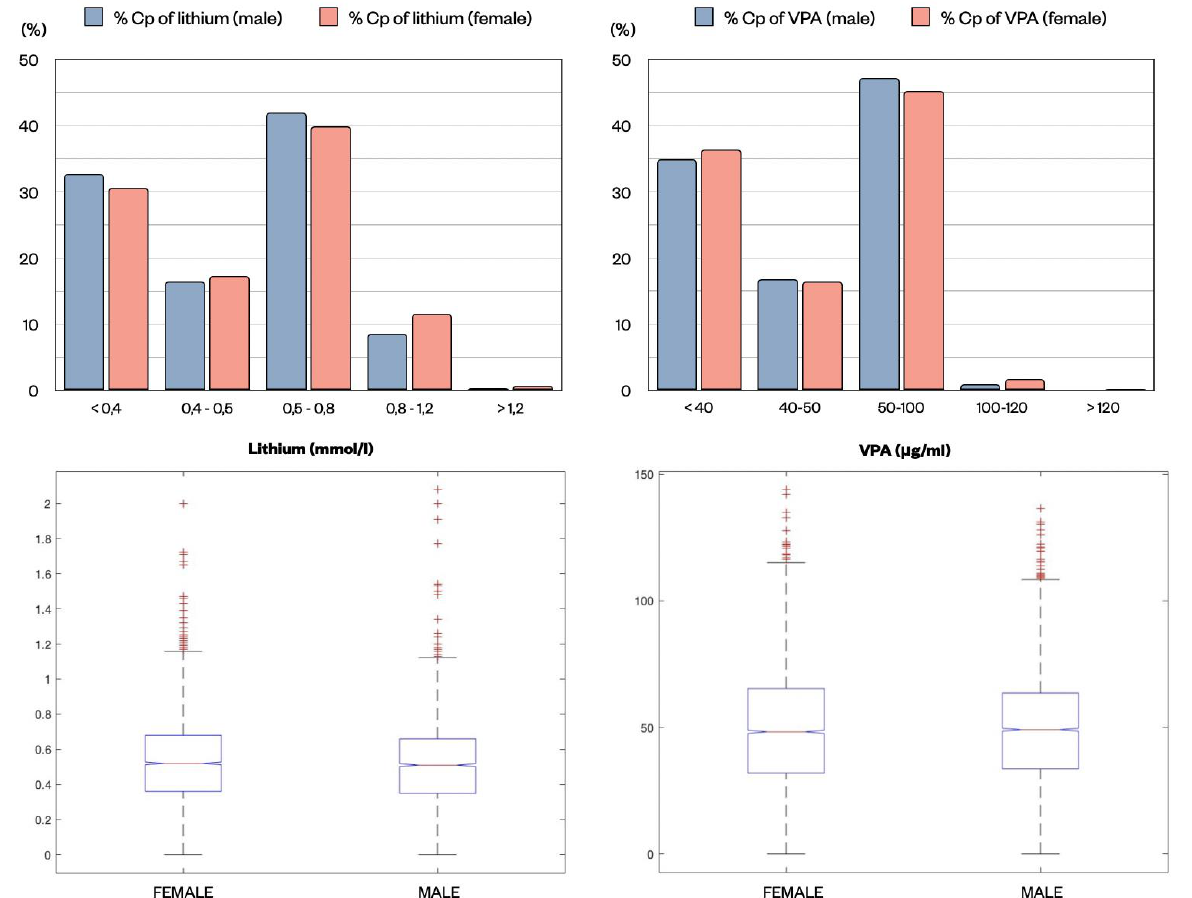
Figure 6. Distribution of lithium (mmol/L) and VPA ( µ g/mL) Cp expressed as percentage in the two subpopulations, males (blue) and females (pink), divided by different therapeutic ranges. No differences were found in the proportions (z-test). Lithium and VPA median concentrations for samples from males and females are reported in the lower graphs, showing highly similar values.